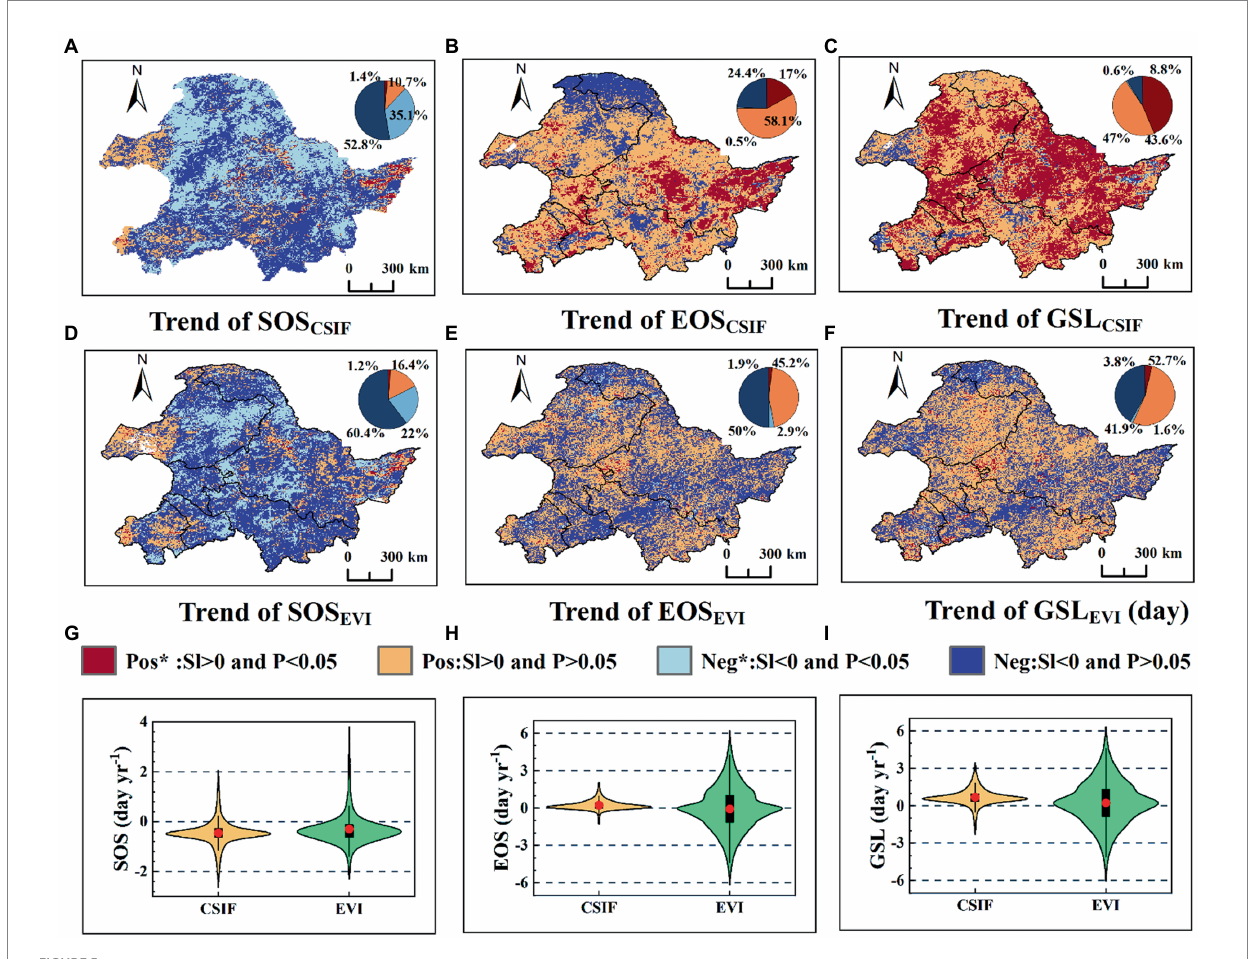
FIGURE 5 Spatial patterns of SOS, EOS, and GSL change rates and significance based on DL extracted CSIF and EVI datasets. (A–C) Spatial patterns of SOS, EOS, and GSL derived CSIF temporal rates of change and significance; (D–F) , Spatial patterns of SOS, EOS, and GSL derived EVI temporal rates of change and significance; (G–I) Violin plots, where red dots indicate means, black rectangular boxes cover the interquartile range, and thin black lines reach the 5th and 95th